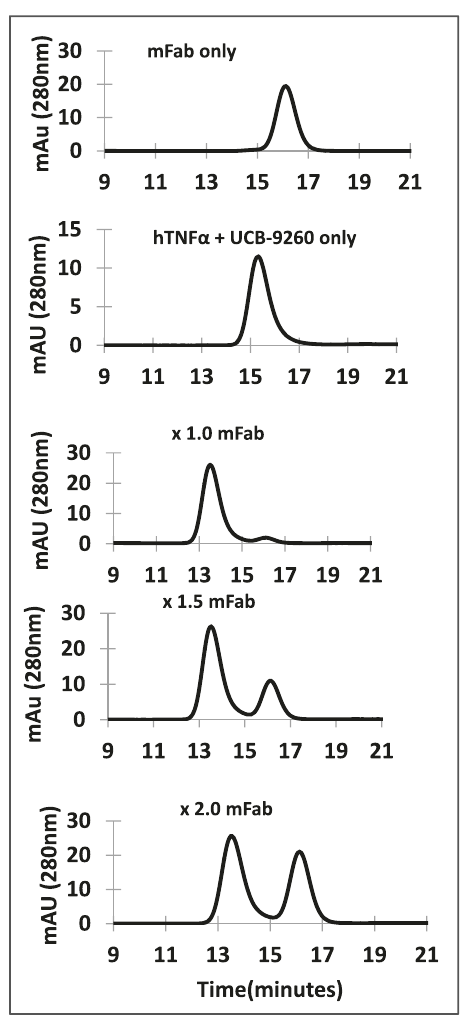
Fig. 2 Stoichiometry assessment of the CA1974-TNF – small molecule complex. A Fab fragment of CA1974 was incubated at various molar-ratios with TNF – UCB-9260 small molecule complex and then analysed by size- exclusion-HPLC. The appearance of only a single high-molecular-weight peak (at approx. 13.5 min) suggests the stoichiometry was 1 Fab: 1 TNF trimer. Source data are provided as a Source Data fi le.